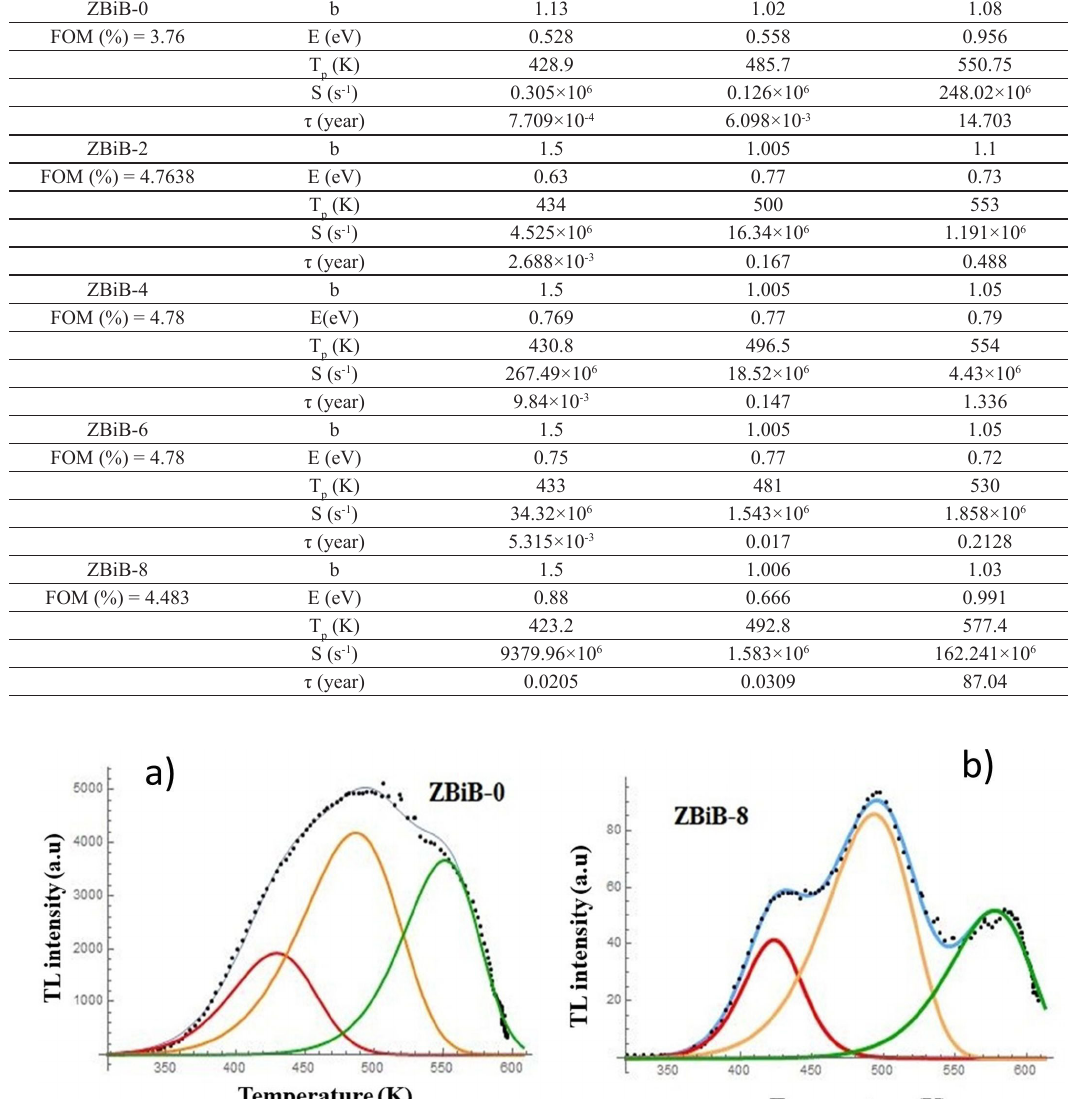
, S and τ) corresponding to the three TL peaks in the case of 5 kGy irradiated ZBiB-0, 2, 4, 6 and ZBiB-8 samples. Table 6. TL parameters (b, E, T p Open window